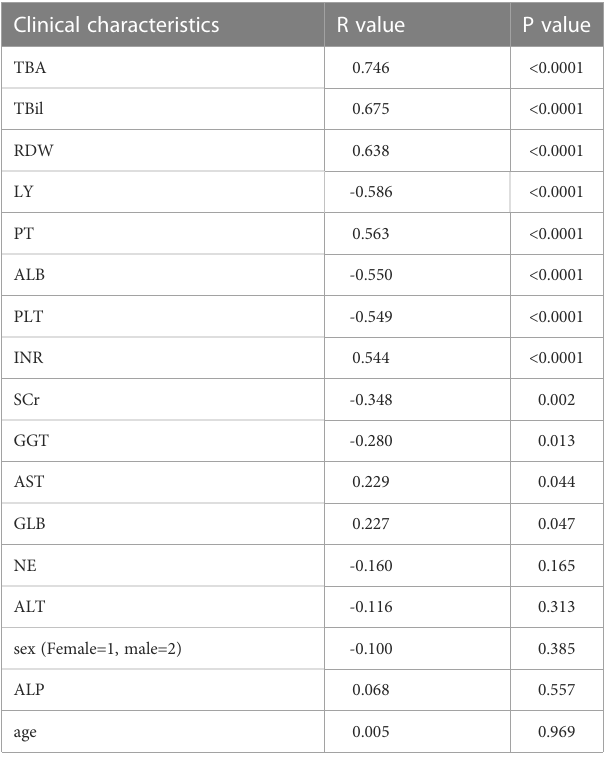
TABLE 3 Correlation analysis between clinical characteristics and histological stages in the model group. Clinical characteristics